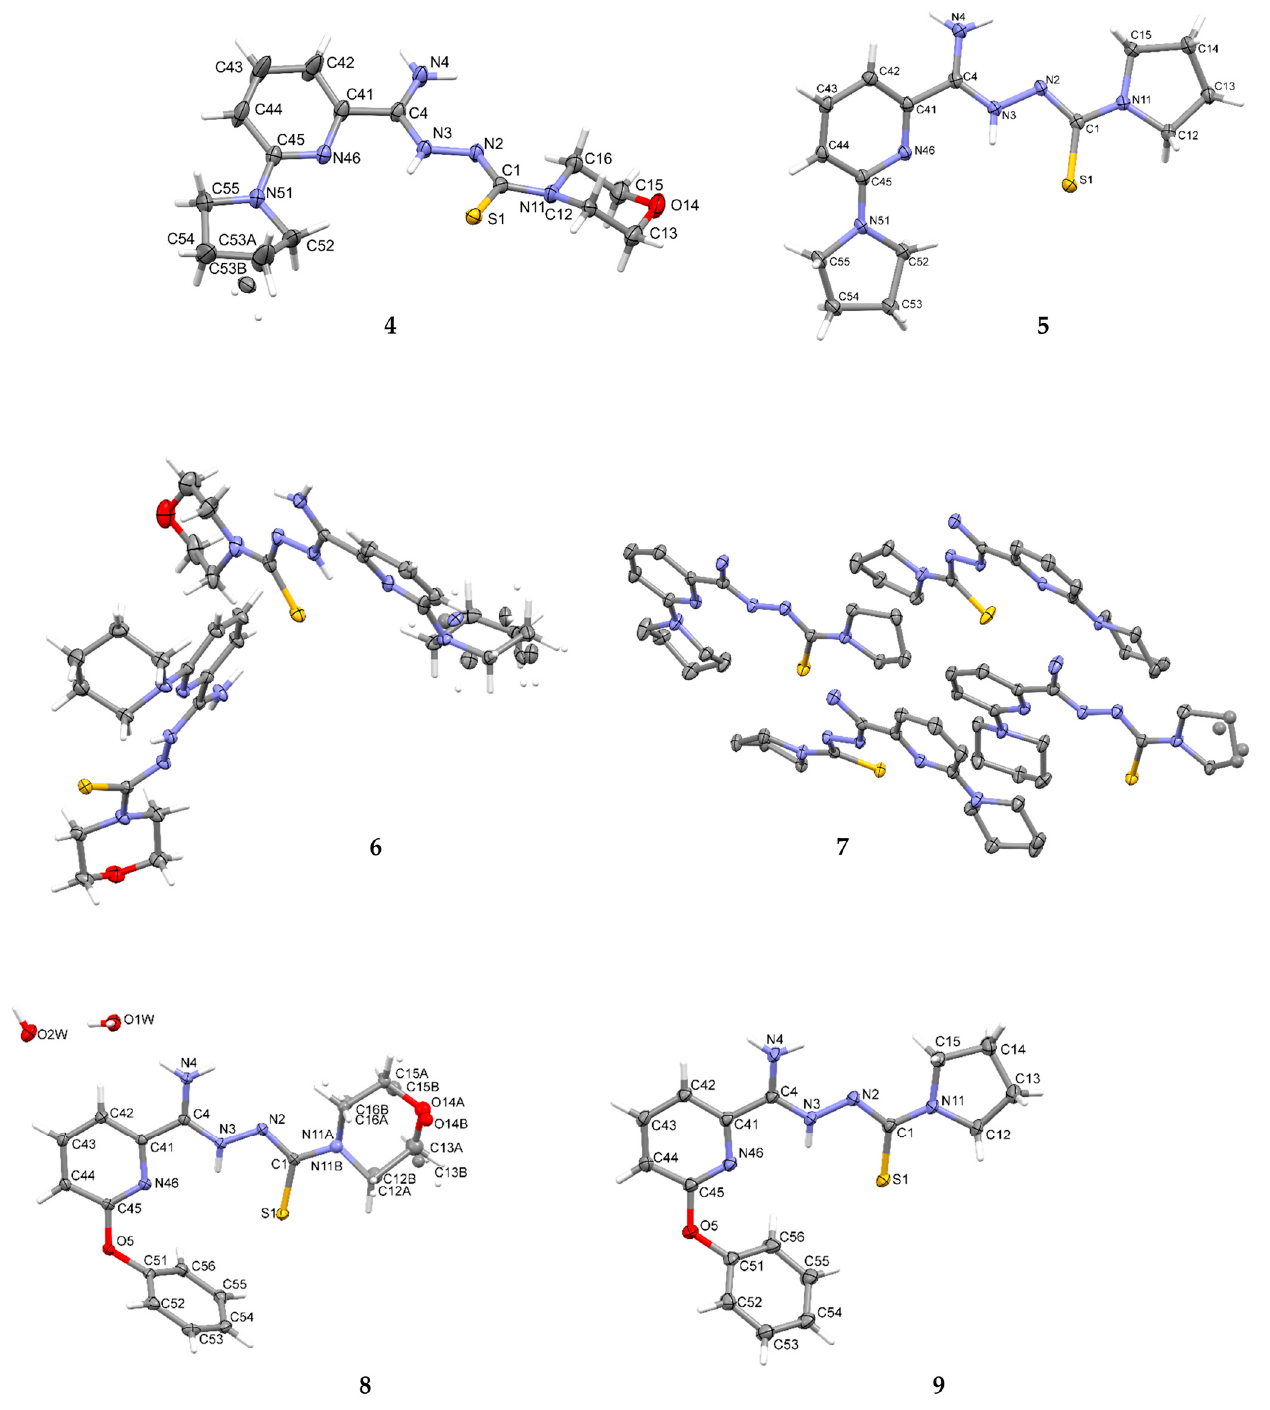
Figure 3. The molecular structures of compounds 4 – 9 showing the atom-labeling schemes. Displace- ment ellipsoids are drawn at the 50% probability level, and H atoms are shown as small spheres of arbitrary radii. Drawings were prepared with Mercury software. Table 6. Hydrogen-bond geometry (Å, °) for 4 .